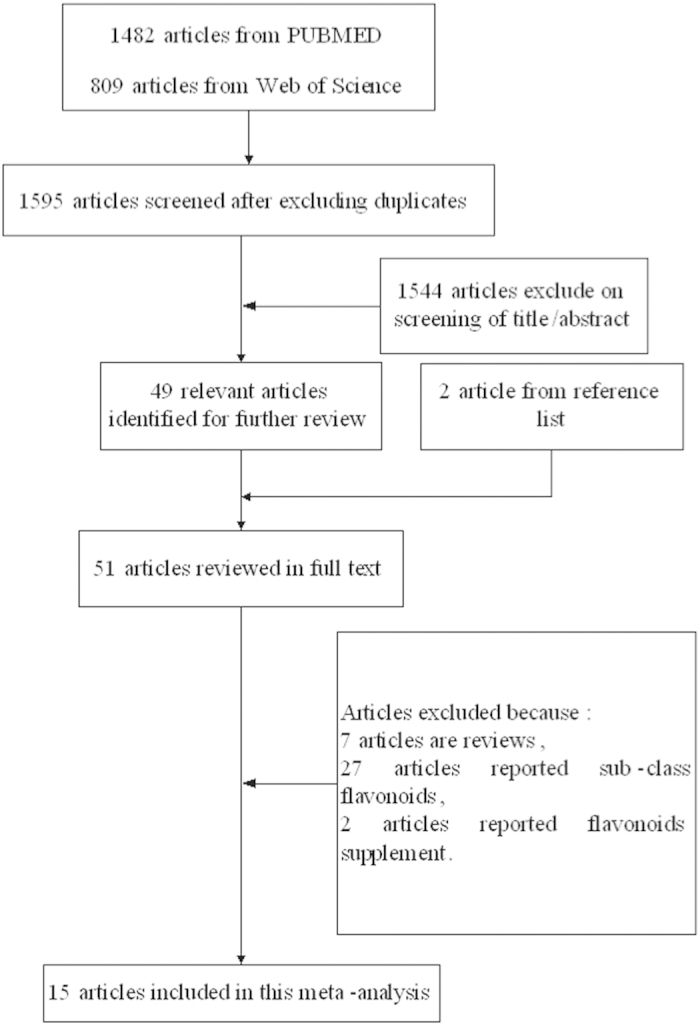
The flow diagram of screened, excluded, and analyzed publications.